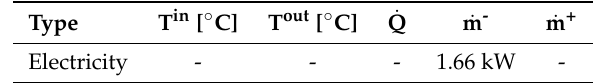
Table A8. Streams for PV panel.